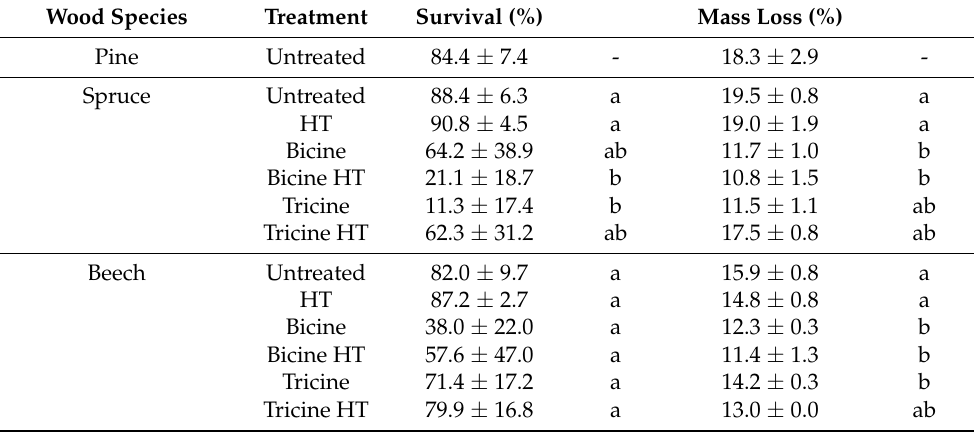
Table 1. Average results of termite survival rates, wood mass loss (%; and standard deviation) for different wood species (pine, spruce and beech) and the treatments: untreated, heat-treated (HT), bicine, bicine and heat treatment (bicine HT), tricine, tricine and heat treatment (tricine HT), after four weeks of exposure. Values followed by different letters within the same column were considered to be significantly different ( p < 0.05; Tukey ´ s honestly significant difference test). The comparisons were made for different treatments within the same wood species.